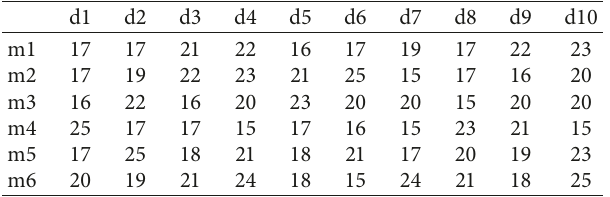
Table 10: Transfer cost of relief goods from distributor to the affected area.